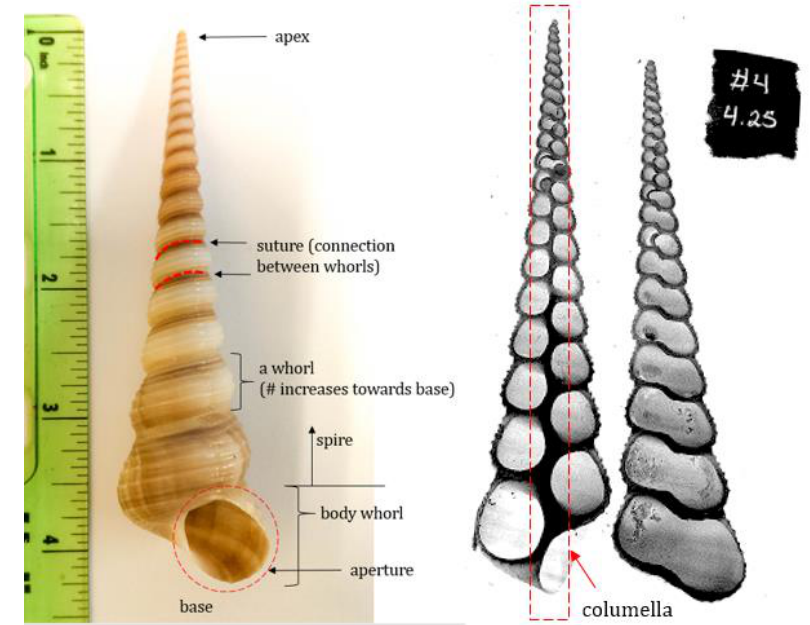
Figure 2. Terminology of the Turritella terebra shell features.